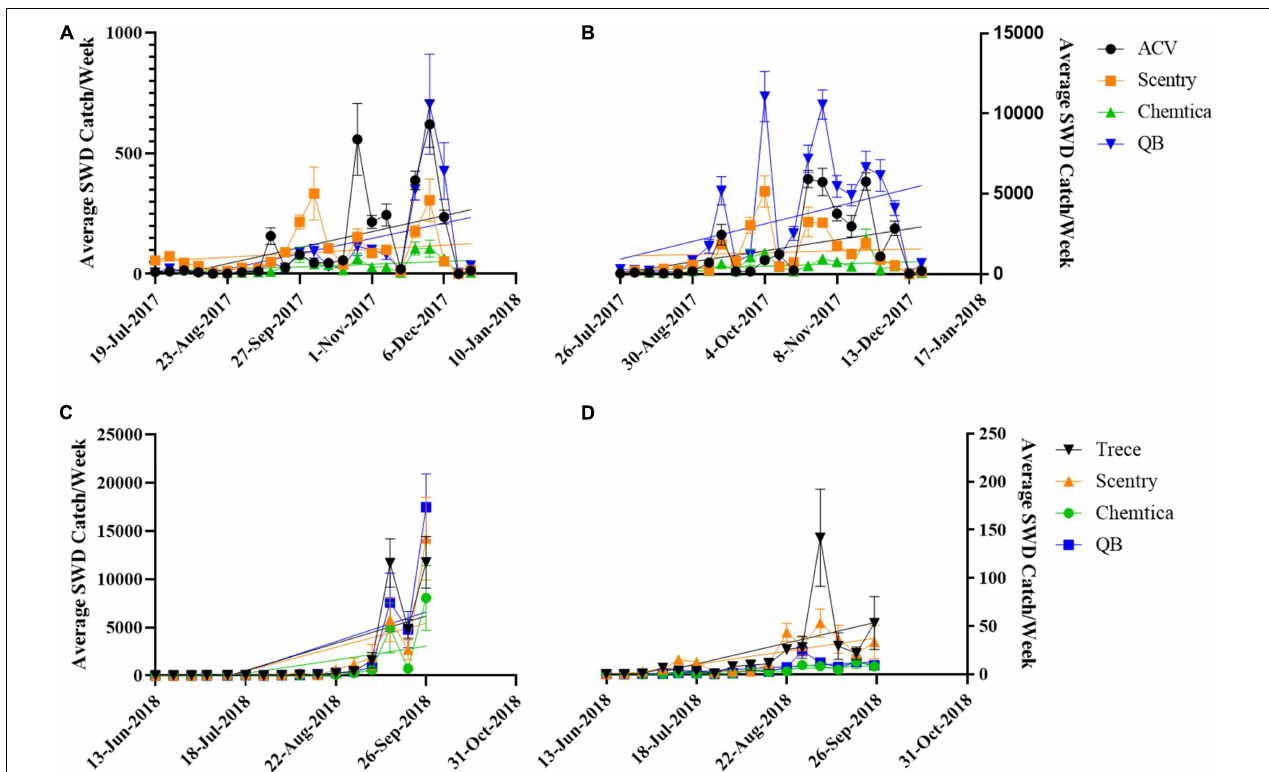
FIGURE 5 | Average capture of SWD per week over the entire 2017 and 2018 trapping periods in Maryland, New Jersey, and West Virginia. (A) Raspberry field in Maryland in 2017 [apple cider vinegar (ACV): Y = 13.28X–23.82, R 2 = 0.1923, Deviation from 0 significant P < 0.0001; Scentry: Y = 3.336X + 52.83, R 2 = 0.03561, Deviation from 0 significant P = 0.0284; ChemTica: Y = 2.317X + 5.56, R 2 = 0.09525, Deviation from 0 significant P = 0.0005; quinary blend (QB): Y = 12.7X–43.35, R 2 = 0.1705, Deviation from 0 significant P < 0.0001]; (B) Wooded area near a raspberry field in Maryland in 2017 (ACV: Y = 137.5X + 68.18, R 2 = 0.1773, Deviation from 0 significant P < 0.0001; Scentry: Y = 21.84X + 1107, R 2 = 0.0064, Deviation from 0 not significant P = 0.3917; ChemTica: Y = 26.73X + 216.7, R 2 = 0.055, Deviation from 0 significant P = 0.0096; QB: Y = 219.7X + 921, R 2 = 0.1457, Deviation from 0 significant P < 0.0001); (C) Blueberry fields in New Jersey in 2018 (Trécé: Y = 565.1X–2301, R 2 = 0.362, Deviation from 0 significant P < 0.0001; Scentry: Y = 496.9X–2026, R 2 = 0.2724, Deviation from 0 significant P < 0.0001; ChemTica: Y = 282.2X–1190, R 2 = 0.1819, Deviation from 0 significant P < 0.0001; QB: Y = 615.6X–2632, R 2 = 0.3064, Deviation from 0 significant P < 0.0001); and (D) Raspberry field in West Virginia in 2018 (Trécé: Y = 4.345X–10.96, R 2 = 0.2086, Deviation from 0 significant P = 0.0001; Scentry: Y = 2.757X–3.547, R 2 = 0.3463, Deviation from 0 significant P < 0.0001; ChemTica: Y = 0.7385X–1.965, R 2 = 0.3869, Deviation from 0 significant P < 0.0001; QB: Y = 1.015X–2.234, R 2 = 0.3929, Deviation from 0 significant P <